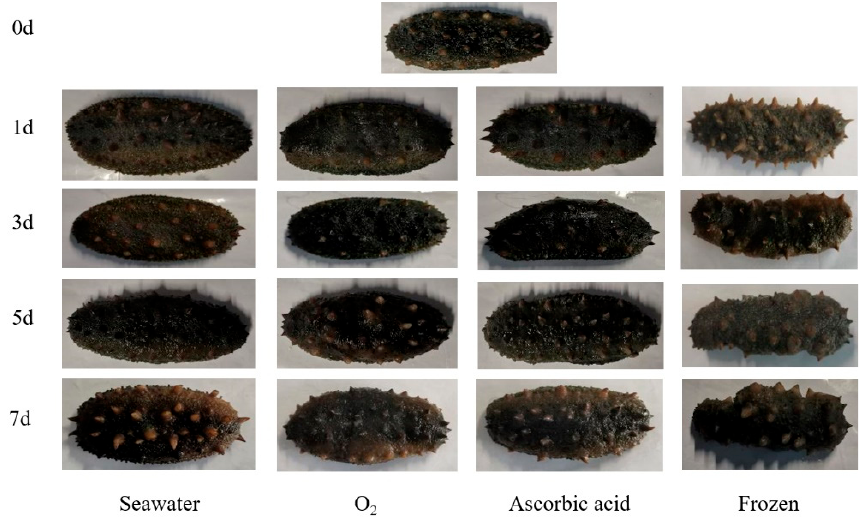
Figure 1. Exterior change of boiled sea cucumbers in different treatment groups during storage.